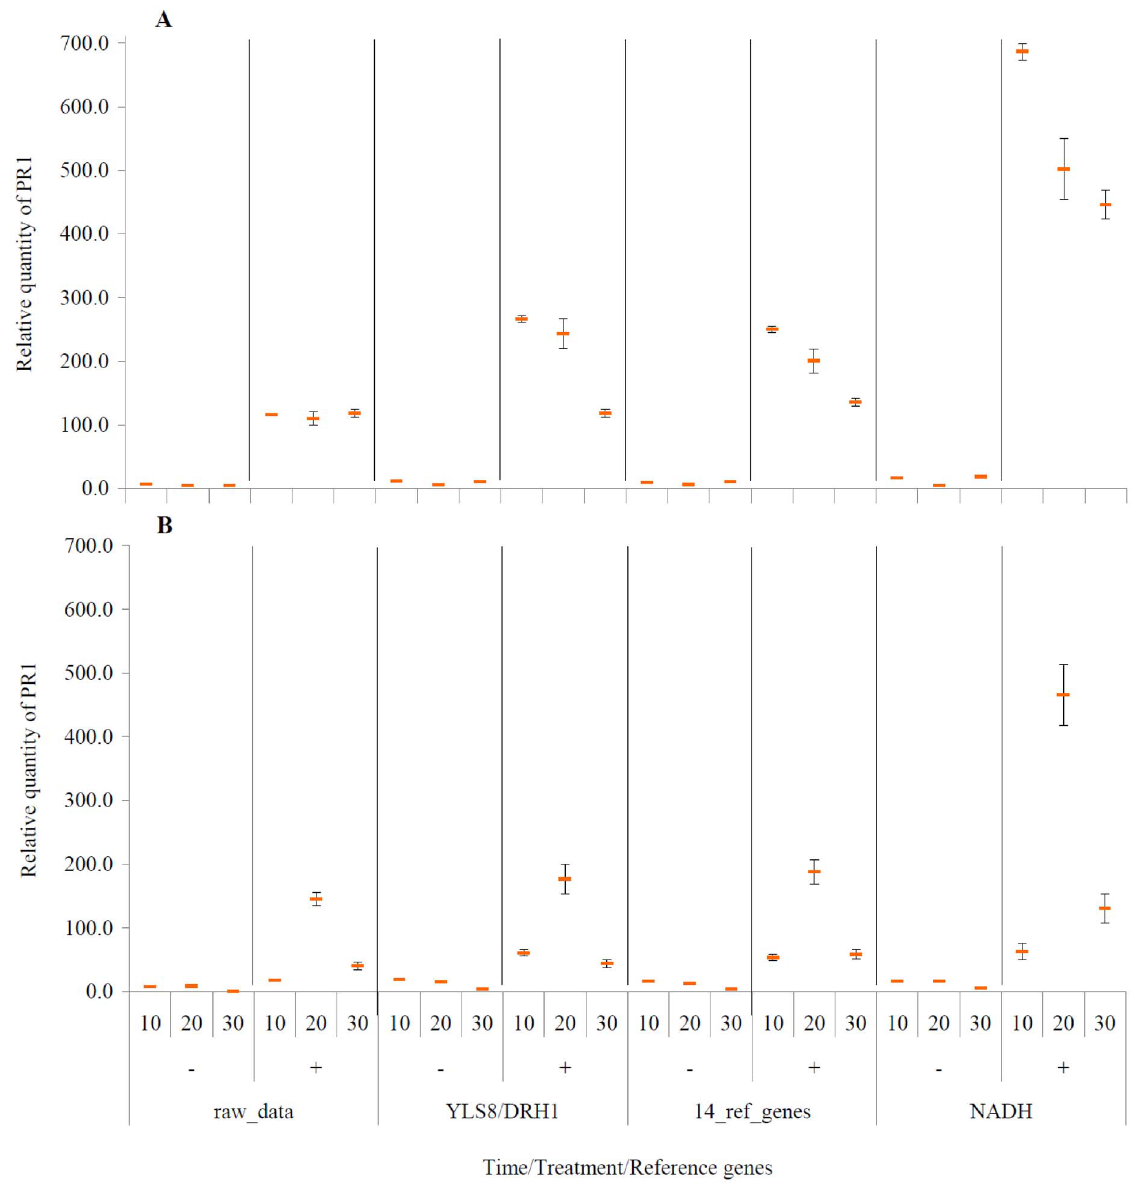
Figure 6. Expression analysis of PR-1 gene in response to V.alboatrum infection. (A) cv. Celeia and (B) cv. Wye Target for infected ( + ) and control plants ( 2 ) at three different experimental time points (10, 20, 30 dpi). Expression values were normalized with three normalization factors: YLS8/DRH1 (two best reference genes), 14 best reference genes (resulting from NormFinder) and least stable gene ( NADH ) and are displayed as normalized and non-normalized (raw) values. Bars indicate standard errors.